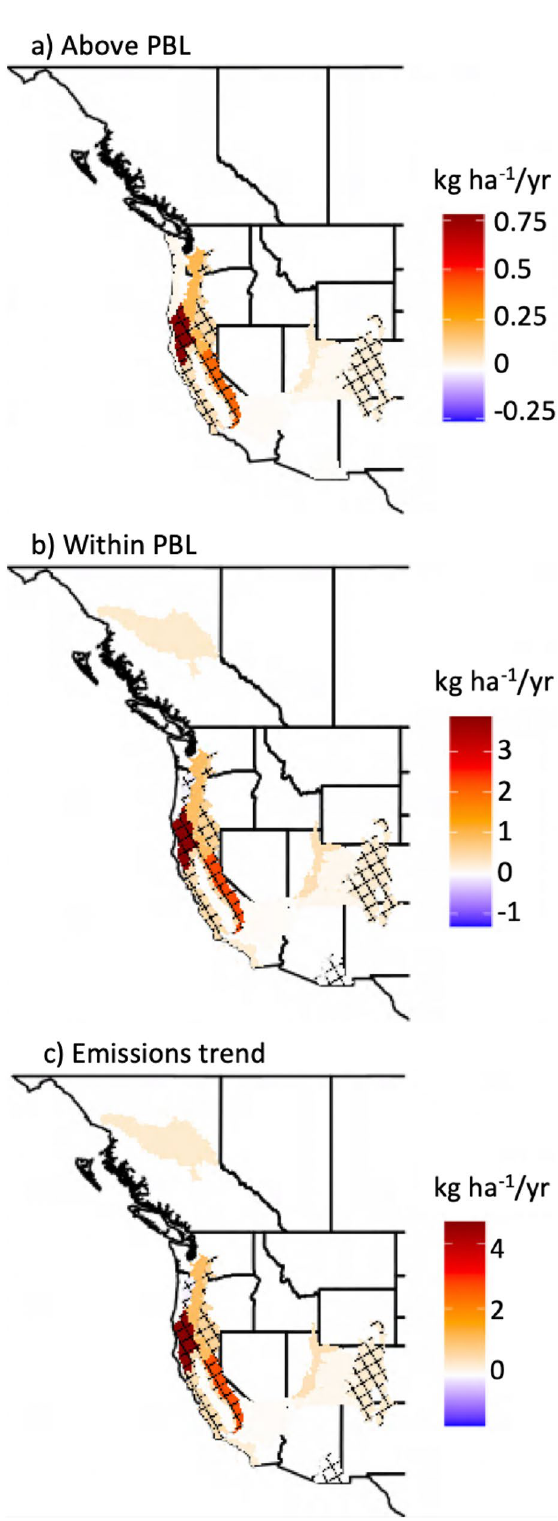
Figure 2. Results for trend analyses of the PM 2.5 mass ( a ) injected above the PBL, ( b ) injected within the PBL, and ( c ) emitted by wildfires for Western US ecoregions and Canadian ecoprovinces during August and September of 2003–2020 based on ~ 4.6 million simulated plume rises. Only trends significant at p < 0.1 are displayed, with a crosshatch overlaid on trends with p < 0.05. Note the differences in the ranges represented by the color bars in ( a–c